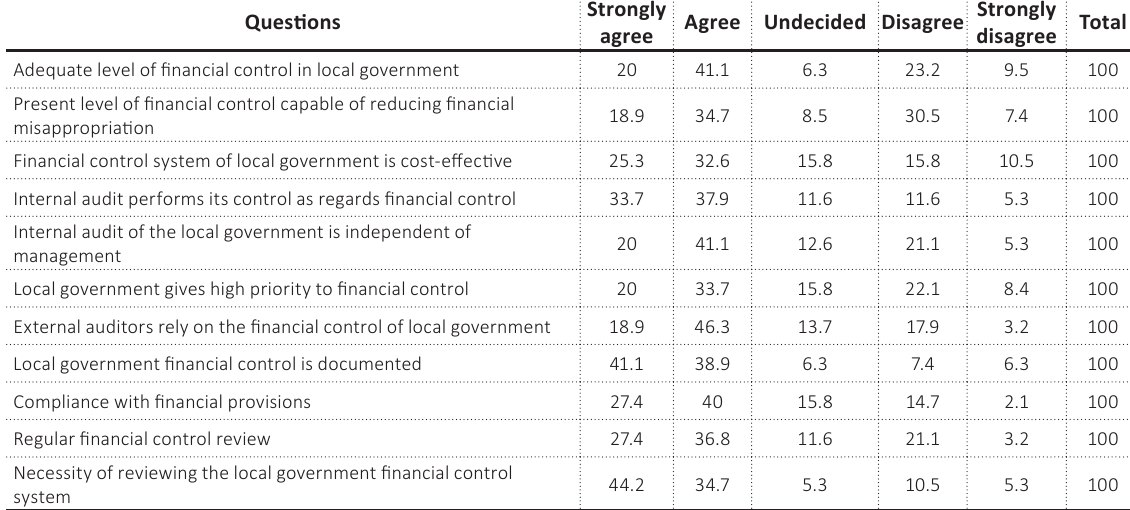
Table 1. Likert scale analysis on the effectiveness of financial control in the public sector of Nigeria